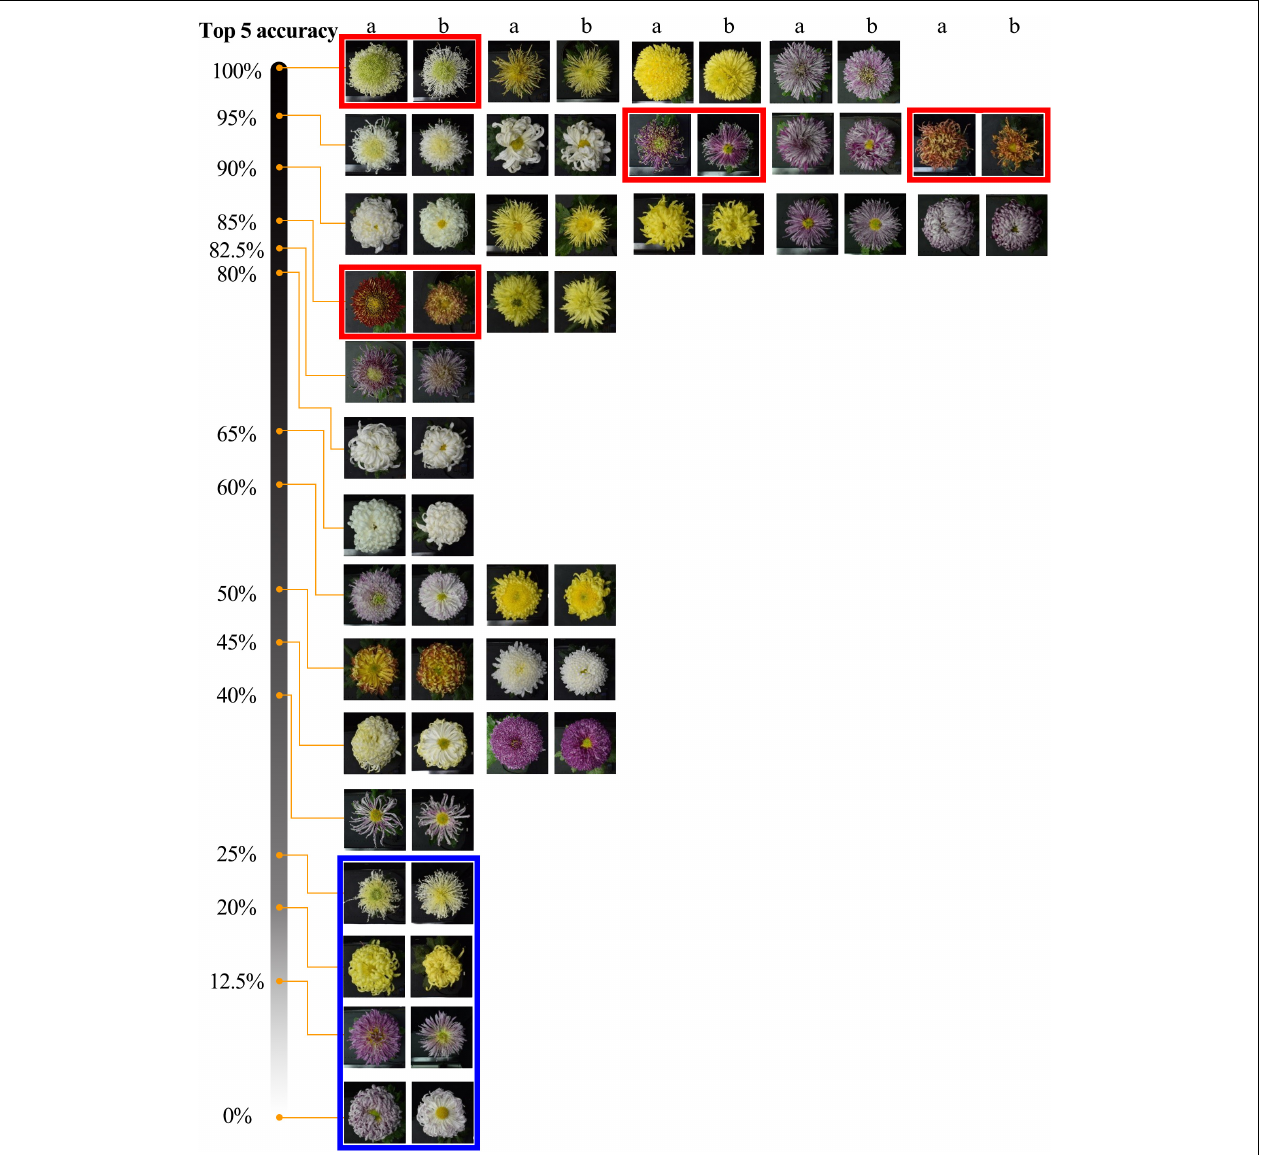
Because the model used the script of the ResNet18 network to avoid used